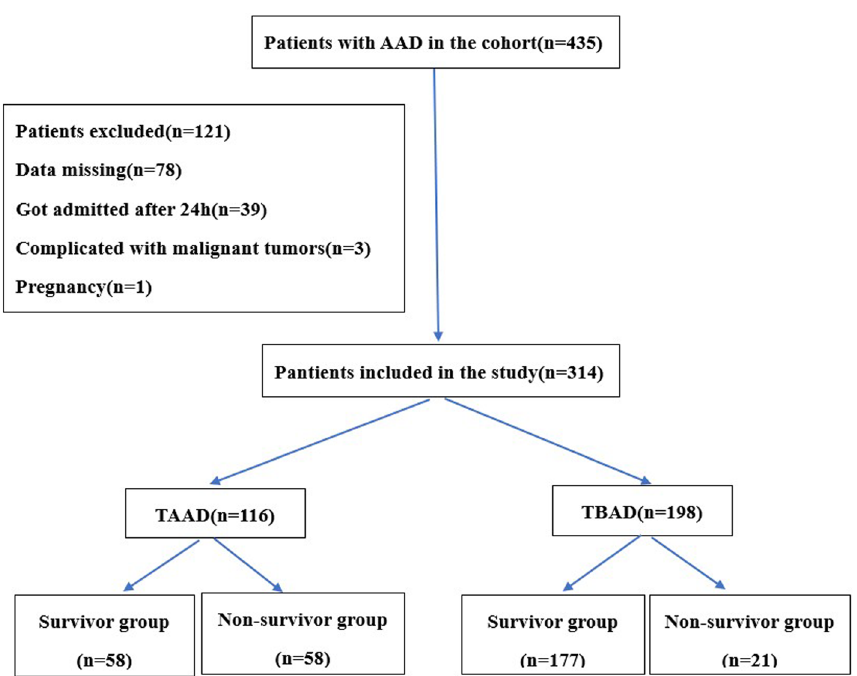
Figure 1. Flow chart depicting patient enrollment and the study design. AAD, acute aortic dissection; TAAD, Stanford type A aortic dissection; TBAD, Stanford type B aortic